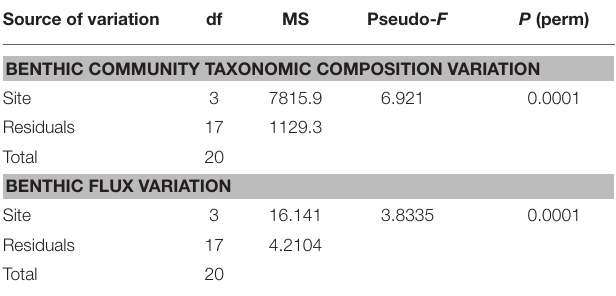
TABLE 3 | Permutational analysis of variance (PERMANOVA) results testing the effect of site on benthic communities based on Bray-Curtis similarity matrices performed on fourth root transformed data, and on benthic fluxes based on Euclidean similarity matrices performed on normalized